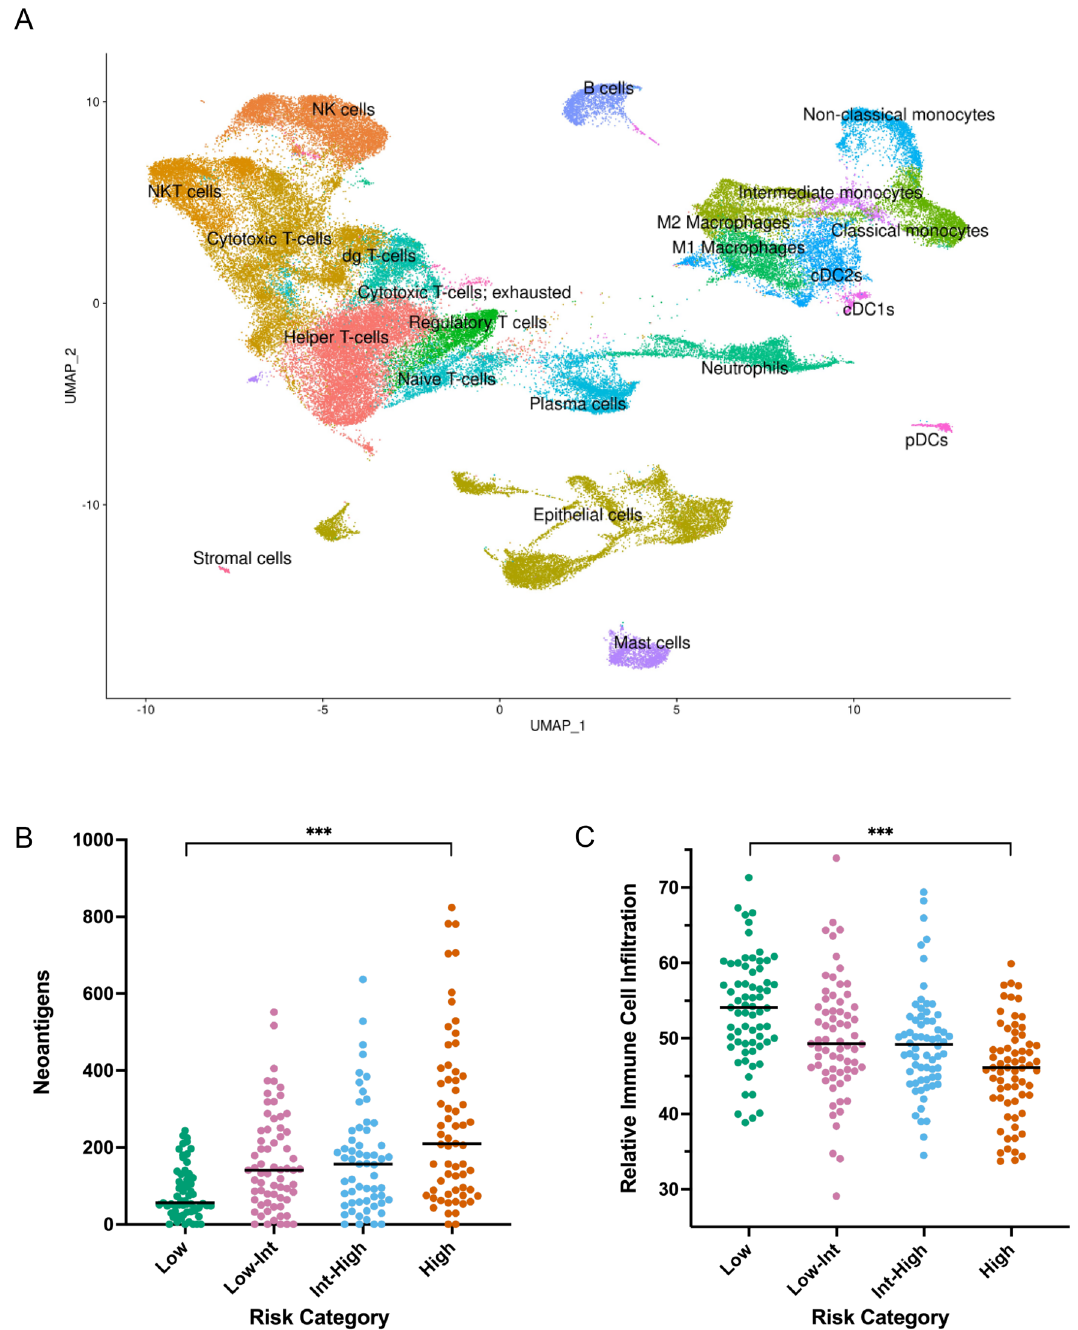
Figure 5. Recurrent stage I lung adenocarcinomas display immune desert phenotypes. scRNA-seq analysis reveals twenty distinct immune cell populations in stage I lung adenocarcinomas ( A ). Despite increasing antigenicity ( B ), tumors with increasing risk of recurrence demonstrate decreasing immune cell infiltration ( C